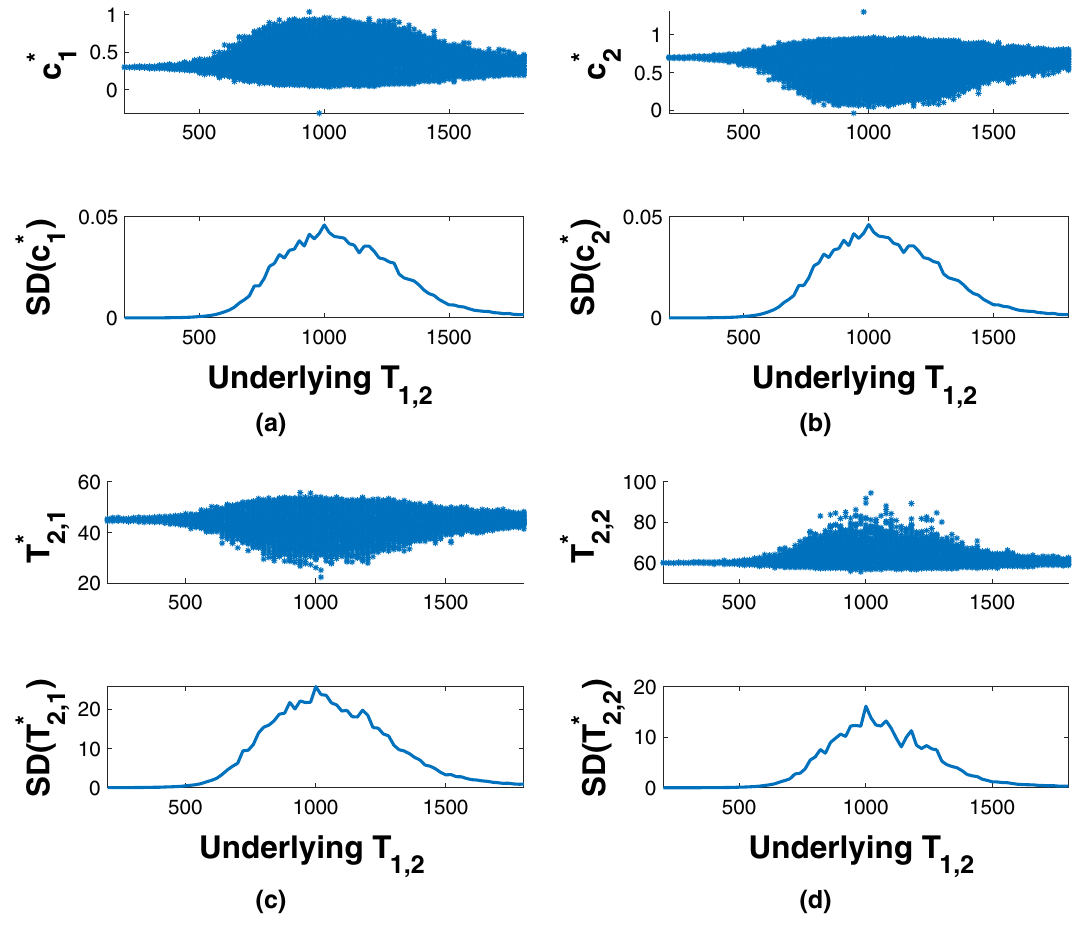
Figure 8. The uppermost and third rows show recovered values of the indicated parameter over 1000 noise realizations, with underlying parameter values fixed at ( 0.3, 0.7, 45 ms, 60 ms, 1000 ms ) , and with T 1,2 varying across the indicated range. The = SD for each recovered parameter as a function of T 1,2 is shown beneath its histogram. The SD’s are largest in the (cid:30) T regime T 1,2 1,1 , and decrease as these values progressively differ. ≈